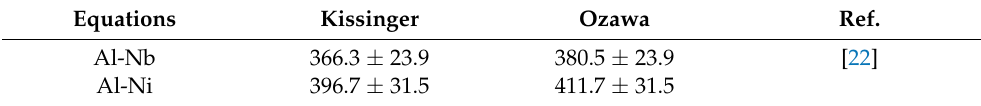
Here, the β is the heating rates, T represents the specific temperature T x , E is the corre- sponding activation energy E x and R is the gas constant. Table 3. Activation energies of crystallization E x estimated with the Kissinger and Ozawa methods. Equations Kissinger Ozawa Ref. Al-Nb 366.3 ± 23.9 Al-Ni 396.7 ± 31.5 411.7 ± 31.5 The curves fitted by the least square method are close to the straight lines, the Adjusted R-square of the fitted curves are higher than 98 and the results of the Kissinger and Ozawa have the same tendency which proves the reliability of the data in Figure 5. The values and standard errors of Al-Ni by Kissinger equation or Ozawa equation are 47.8, 3.8 and 49.6, 3.8, respectively. By formula calculation, it is clear that the E x value of Al-Ni is higher than that of Al-Nb by Kissinger equation or Ozawa equation. It indicates that higher energy barrier is needed for the Al-Ni crystallization, which is agreement with the higher stability of amorphous state and GFA in comparison with Al-Nb amorphous alloys.